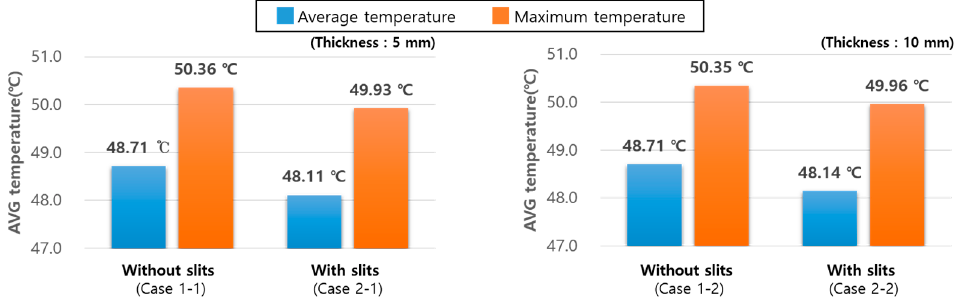
Figure 11. Variation of PV temperature as a function of slits (Length: 30 mm, Number: 10EA).